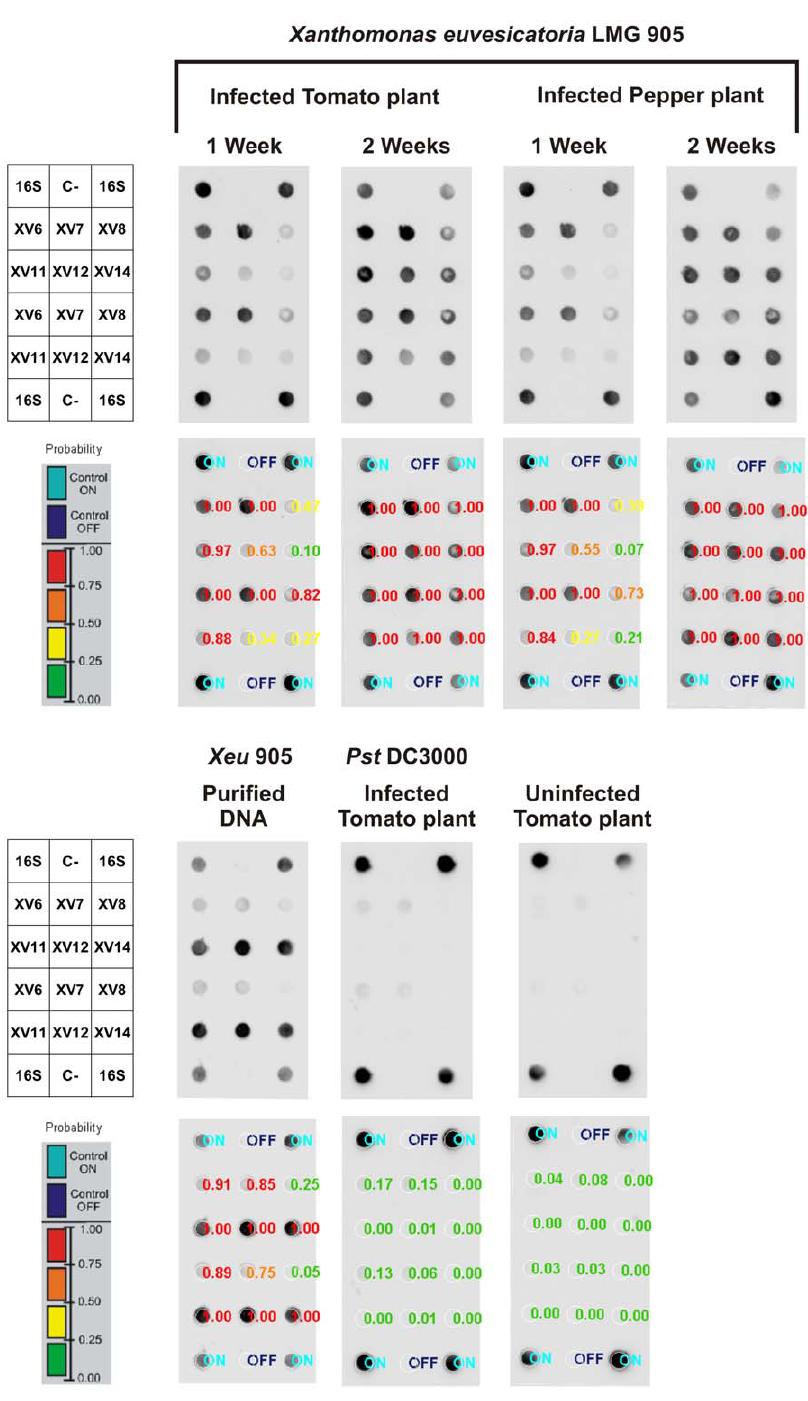
Figure 6. Detection of BSX in infected plant material using an inverted dot blot platform. Crude bacterial suspensions, obtained from tomato and pepper plants leaves after one and two weeks of infection with Xeu 905, were used as templates for PCR enrichment using the markers’ primer pairs. PCR products corresponding to each plant were labeled with Digoxigenin and used as probes. Purified DNA from Xeu 905 was used as positive control. Negative controls consisted of tomato plants infected with Pst DC3000 for 2 weeks and uninfected plants. The raw ChemiDoc captures and processed images, using the automatic image analysis algorithm, are shown.